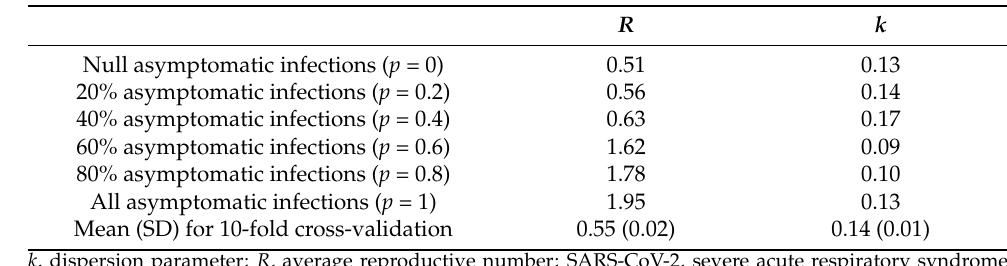
Table 3. Sensitivity